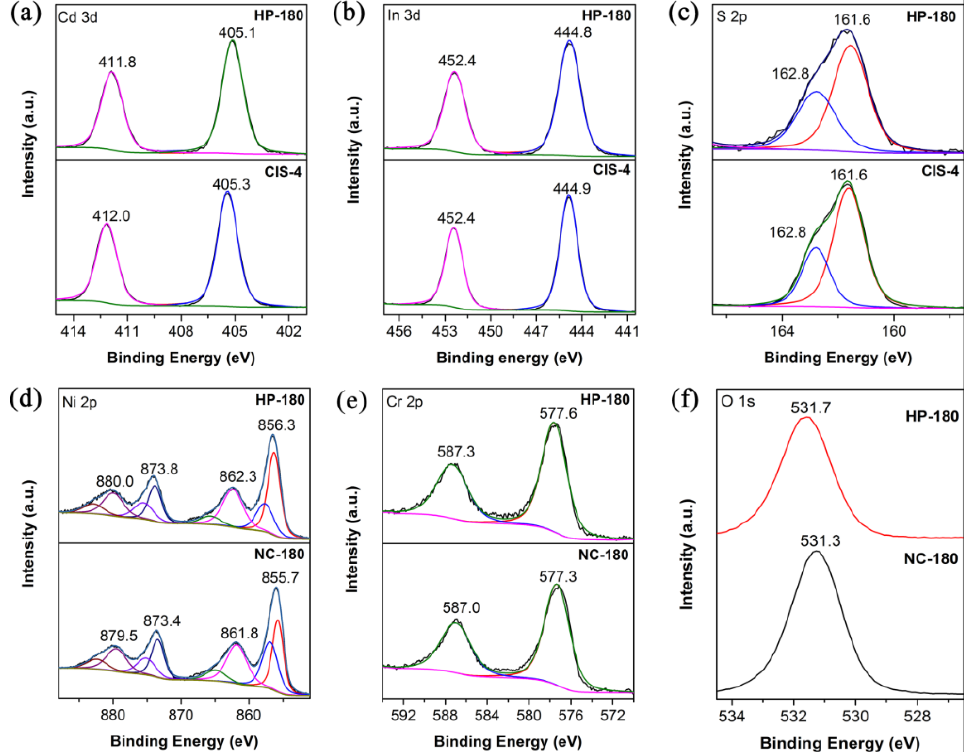
Figure 4. High ‐ resolution XPS spectra of CIS ‐ 4, NC ‐ 180 and HP ‐ 180 ( a ) Cd 3d, ( b ) In 3d, ( c ) S 2p, ( d ) Figure 4. High-resolution XPS spectra of CIS-4, NC-180 and HP-180 ( a ) Cd 3d, ( b ) In 3d, ( c ) S 2p, Ni 2p, ( e ) Cr 2p, ( f ) O 1s spectra. ( d ) Ni 2p, ( e ) Cr 2p, ( f ) O 1s spectra.